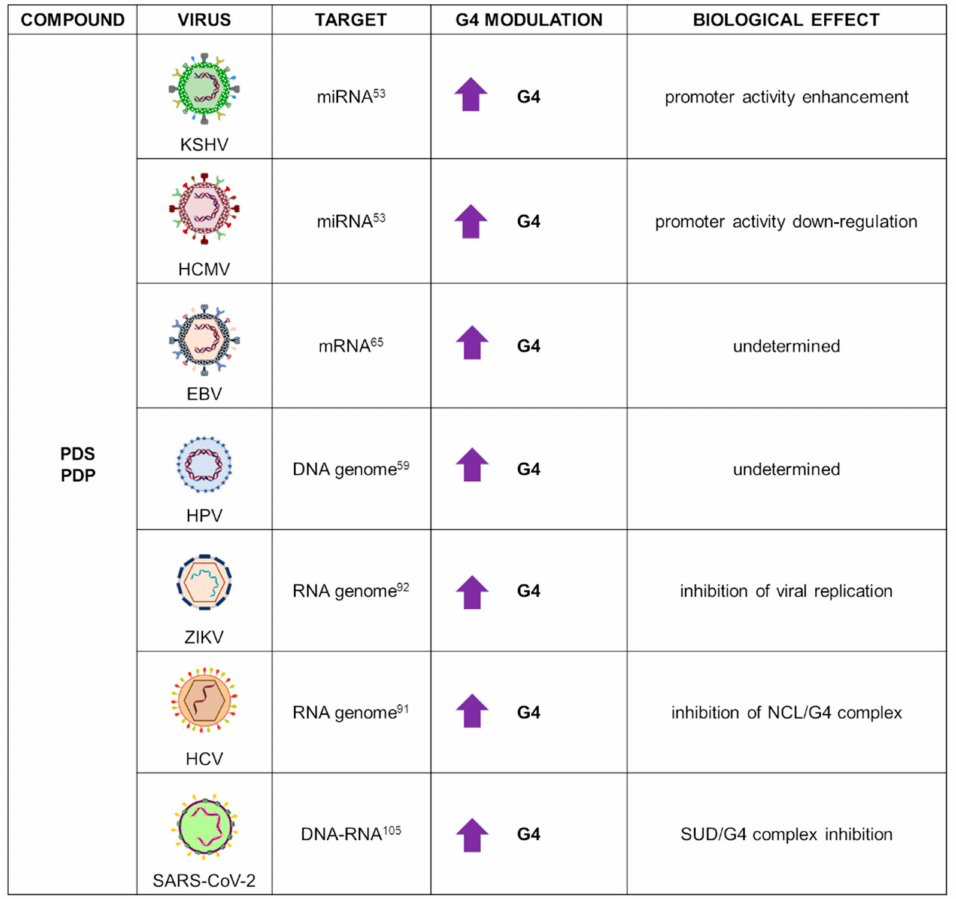
Figure 7. Summary of PDS and derivative applications as G4 ligands in virology. For each target virus, the site of action (also known as the G4 location), the modulatory effect on G4s, and the overall biological outcome are